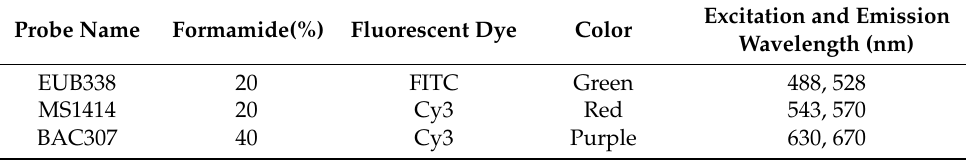
Table 2. The 16S rRNA-targeted oligonucleotide probes and hybridization conditions.